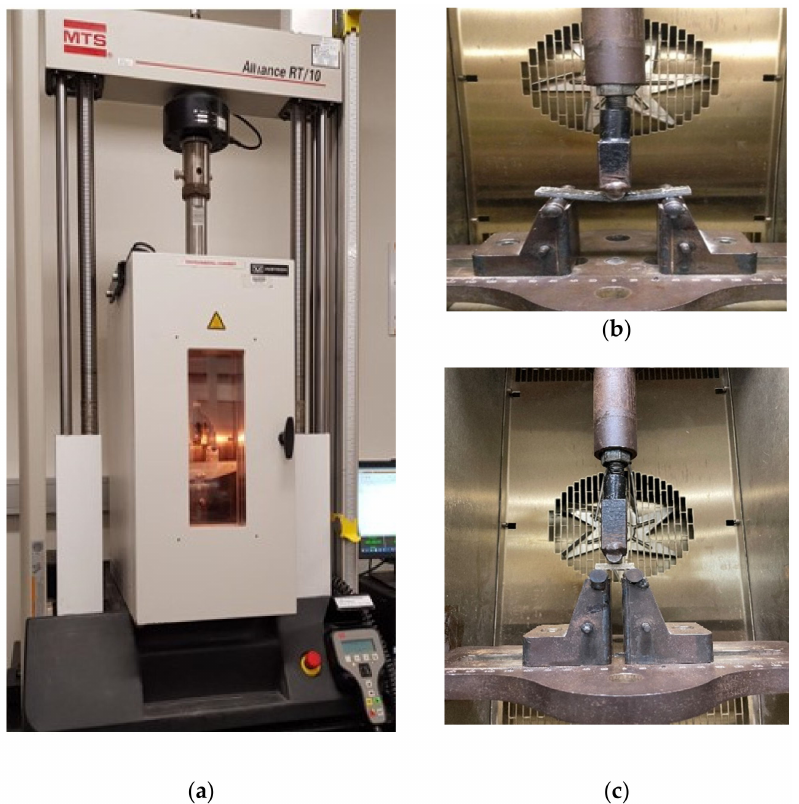
Figure 2. Mechanical tests for flax composites with various weights of graphene: ( a ) Instron Environ- mental Chamber; ( b ) Flexural Test; ( c ) Interlaminar